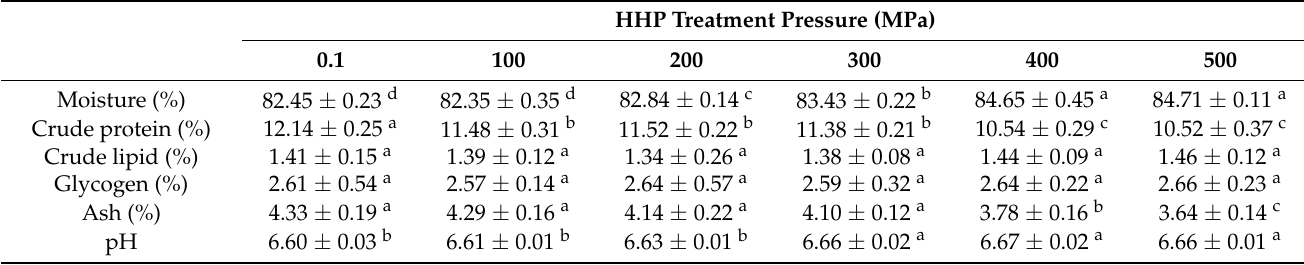
Table 1. Effects of HHP treatment on proximate composition and pH of